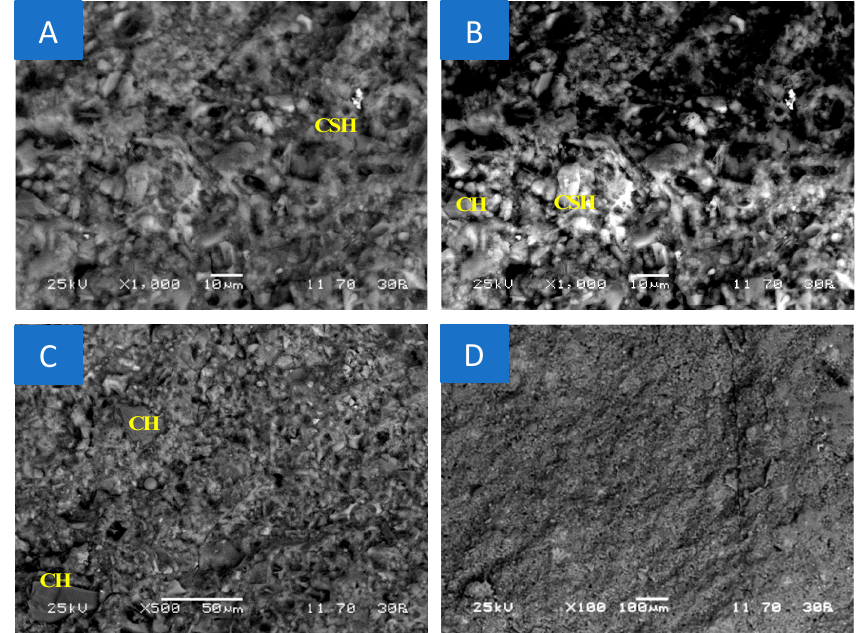
Figure 16. BSC micrograph of B10-PC60LS40 28D at ( A ) 1000× magnification, ( B ) 1000× magnification, ( C ) 500× magnification and ( D ) 100× magnification.